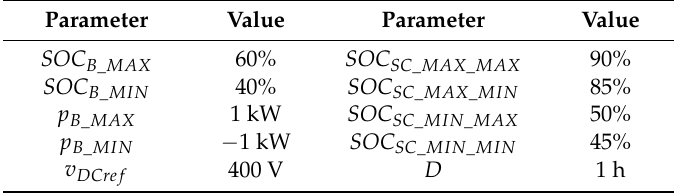
Table 2. Arbitrary values and constraints.